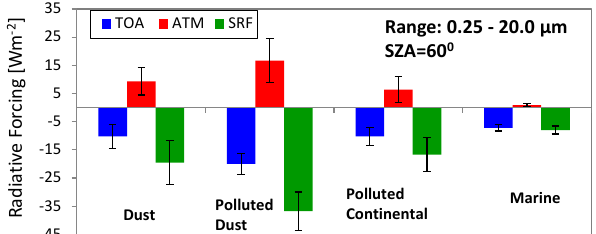
Figure 12. Day time average radiative forcing at top of the atmo- sphere (TOA), at surface (SRF) and in the atmosphere (ATM) for various dominant aerosol types over eastern Mediterranean during summer 2010. The error bars present the error in calculation of radiative forcing associated with errors in major input parameters (AOD, SSA and